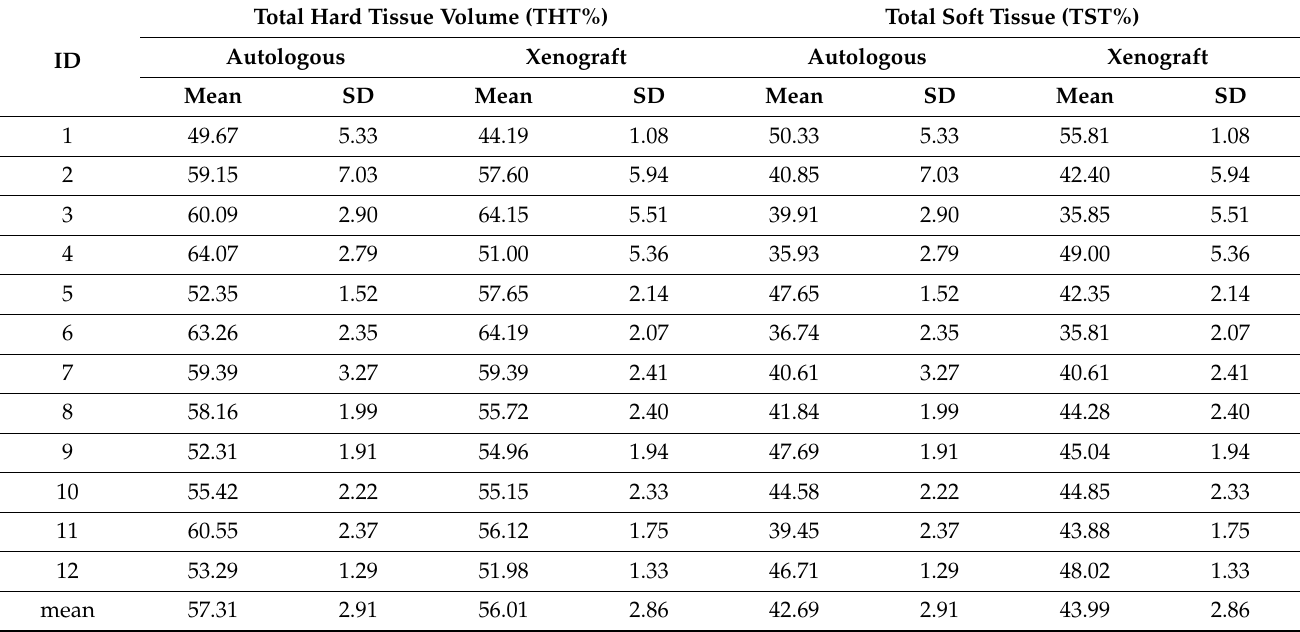
Table 2. Histomorphometric results: mean and standard deviation (SD) of 10 slides per patient side (ID) according to the group in terms of % of total hard tissue and total soft